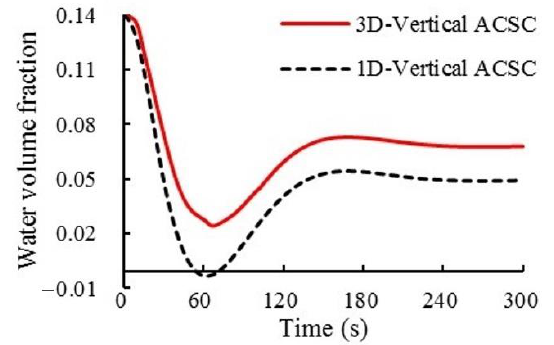
Figure 6. Difference of variation of water volume fraction between 1D and 3D models.